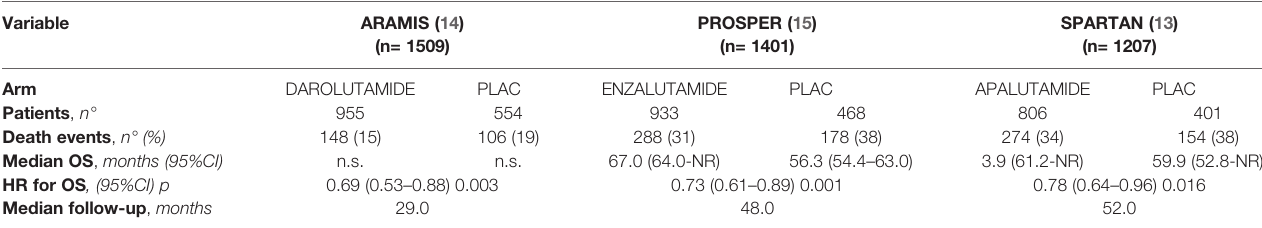
TABLE 2 | Overall Survival (OS) data from the fi nal analyses of the three included